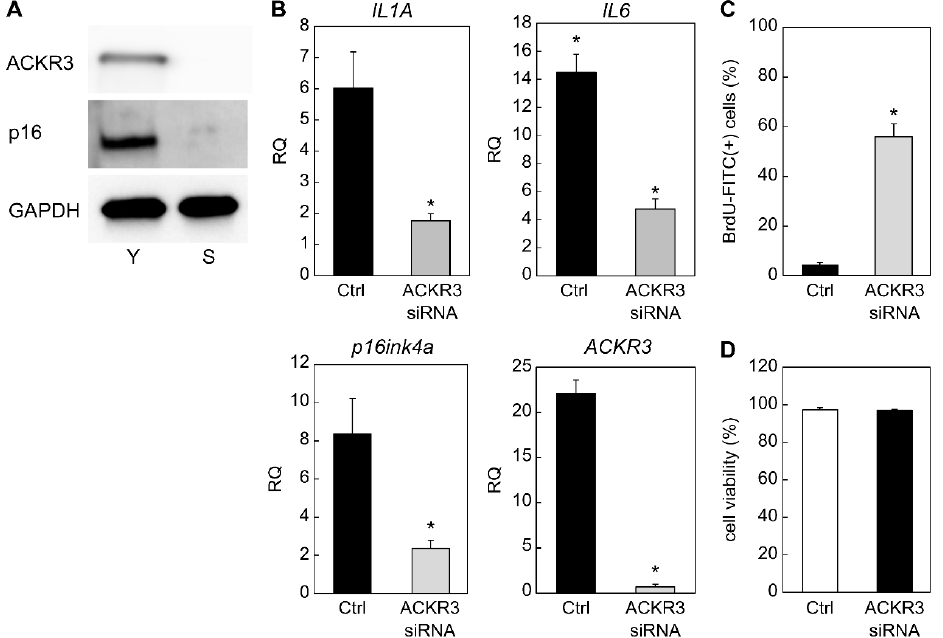
Figure 2. Effect of ACKR3 siRNA knockdown on senescent cells. ( A ) Western blot analysis to con- firm ACKR3 knockdown and its effect on senescence. ( B ) RT-PCR analysis of the expression of senescence-related genes. GAPDH was used as the housekeeping gene. ( C ) Increased BrdU absorption after transfection with ACKR3 siRNA. ( D ) Cell viability was not altered by ACKR3 siRNA transfec- tion. *; p < 0.05. All experiments were performed in triplicate. Ctrl: negative control siRNA.